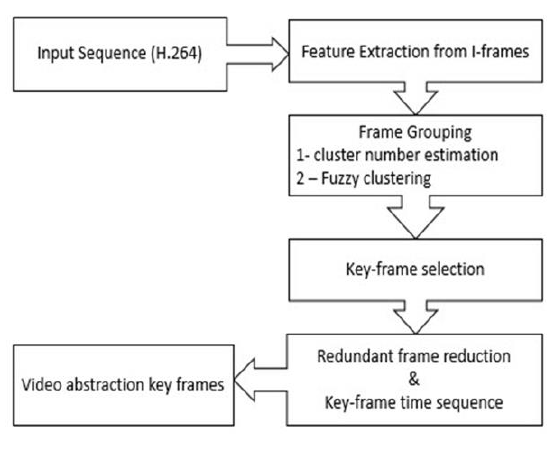
Figure 4. Our proposed